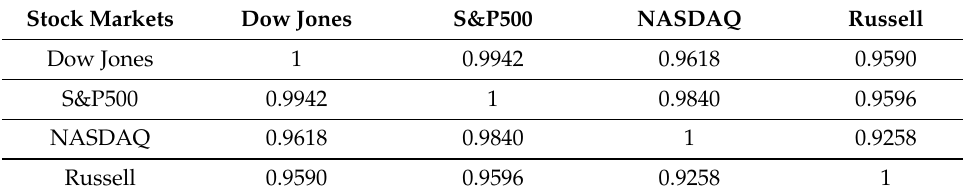
Table 2. Correlation matrix for stock markets.